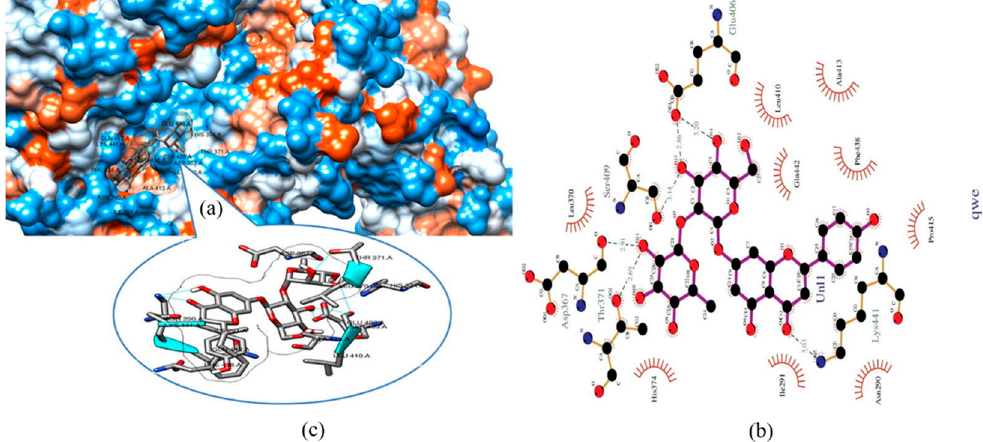
Figure 5. Binding pose ( a ) along with 2D ( b ) and 3D ( c ) analysis of molecular interaction of naringin within the active site of S protein. Reproduced with permission from Jain et al. [78], Saudi Journal of Biological Sciences, Elsevier,